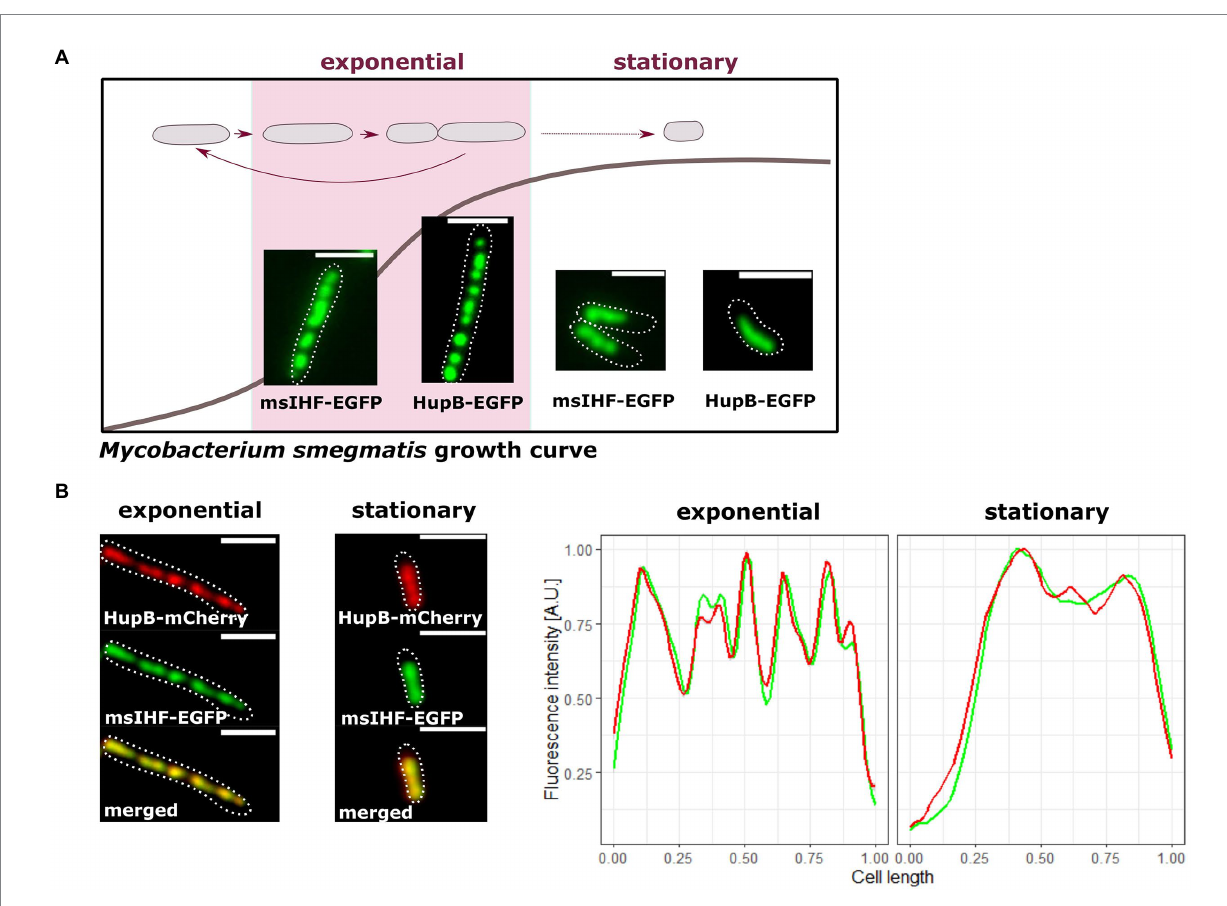
FIGURE 1 Comparison of the subcellular localizations of msIHF-FP and HupB-FP in M. smegmatis . (A) Representative cells of msIHF-enhanced green fluorescent protein (EGFP) and HupB-EGFP strains at the exponential and stationary phases of growth. (B) Colocalization of msIHF and HupB in M. smegmatis cells producing both proteins fused to EGFP and mCherry fluorescent proteins, respectively, instead of the native versions. Green and red fluorescence profiles collected from representative cells overlap, confirming the colocalization of the analyzed NAPs. Cell outlines are indicated with dotted white lines. Scale bar, 2 μ